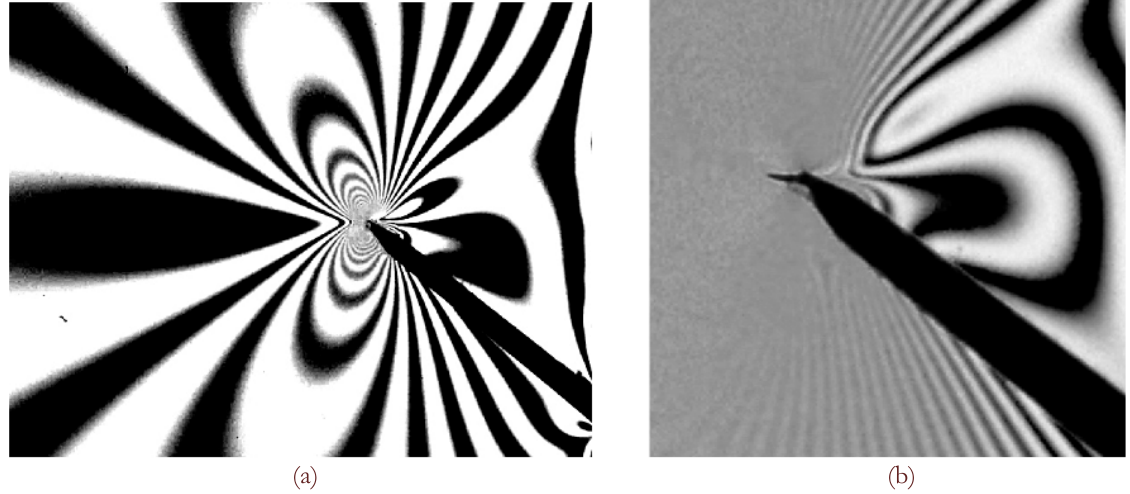
Figure 15: Photoelastic images for a straight crack in mixed Mode I&II. Fringe pattern before cracking (a) and after kinking (b). From Al Bin Mousa [13].